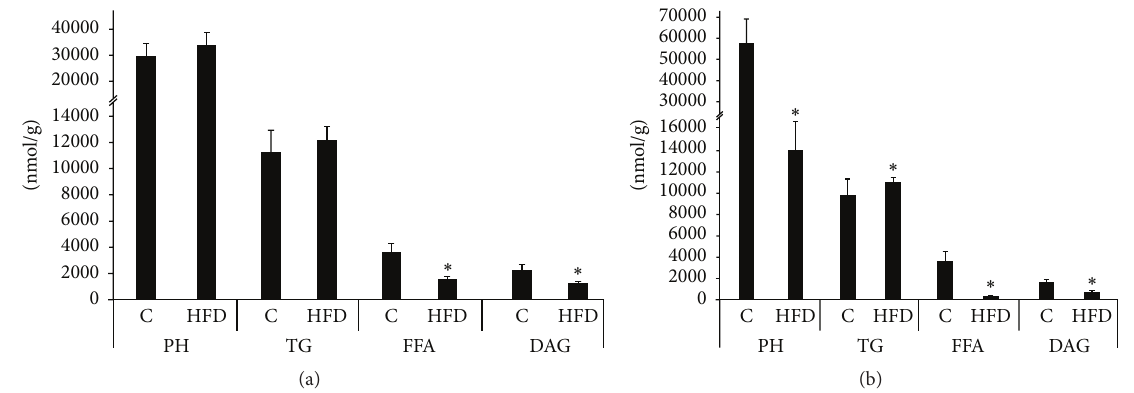
Figure 1: Effects of high fat diet feeding on the salivary glands lipid profile ((a) parotid salivary glands; (b) submandibular salivary glands). Ctrl: control group ( 𝑛 = 8 ); DG: diacylglycerols; FFAs: free fatty acids; HFD: high fat diet fed group ( 𝑛 = 8 ); PH: phospholipids; PSG: parotid salivary glands; SMSG: submandibular salivary glands; TG: triacylglycerols; ∗ : difference versus Ctrl ( 𝑝 < 0.05 ).